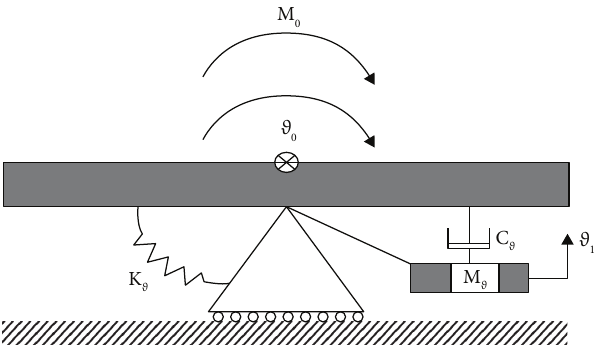
Figure 3: Spring-dashpot-mass model with an additional internal degree of freedom for the rotational degree of freedom [37]. Table 2: Detailed parameters for the springs used to consider the SSI